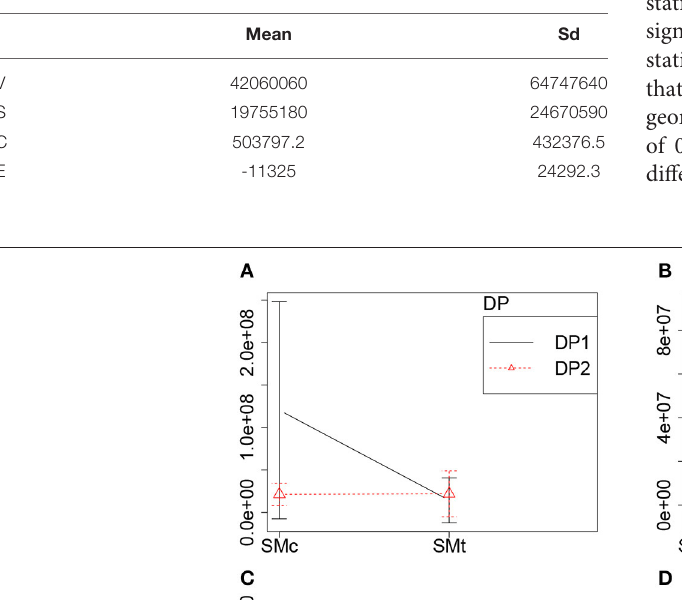
Frontiers in Environmental Science |